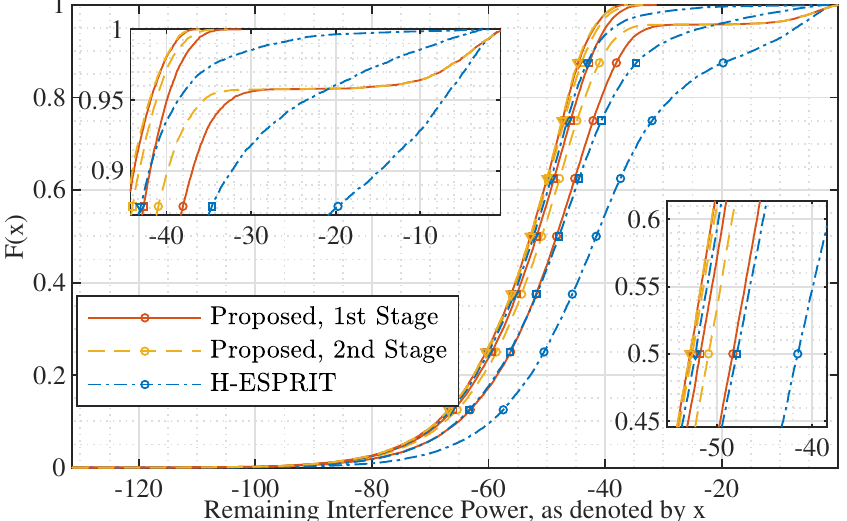
Figure 7. CDF of interference power after subarray beamforming, where N = 16. The curves with = − 10 dB, − 4 dB, and 8 dB, circle, square, and triangle markers are for σ 2 i